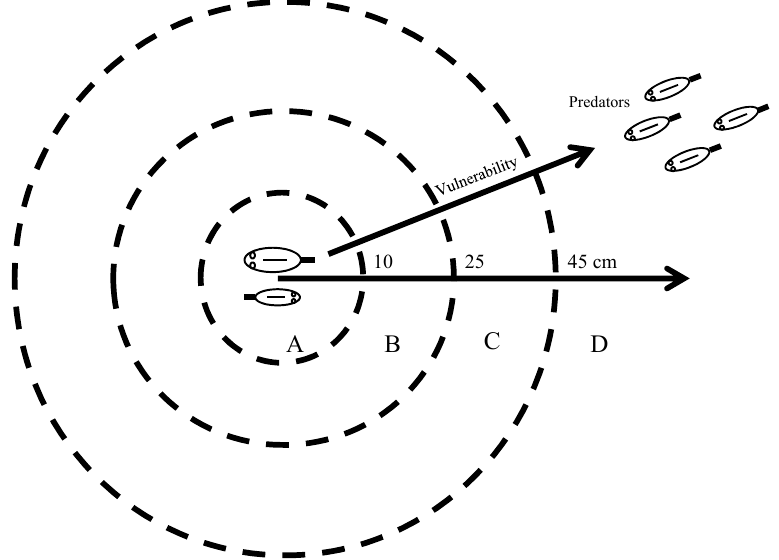
Figure 14. Geometry of brood defense in convict cichlids in Río Cabuyo that incorporates data on parental attack distances, brood radius data and the trade-off for fry between maximizing foraging while minimizing risk of predation. A, zone of intimidation where physical presence of parents deters approach of brood predators. Very small fry from Río Cabuyo stay here and small and medium-sized fry from Laguna de Xiloá stay here; B, transition zone where fry can expand into when their swimming performance and predation risk warrants it; C, zone of interception to maintain a predator-free buffer around the brood; D, zone of escalated attack, particularly for juveniles of the piscivore P. dovii . The evolution of parental care in cichlids is a three-way process between brood predators, ontogeny of antipredator competence in the fry, and parental area defense.